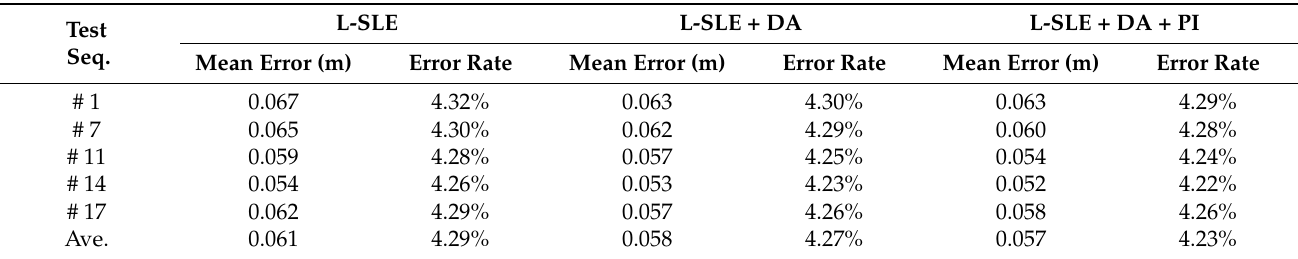
Table 3. Effect of data